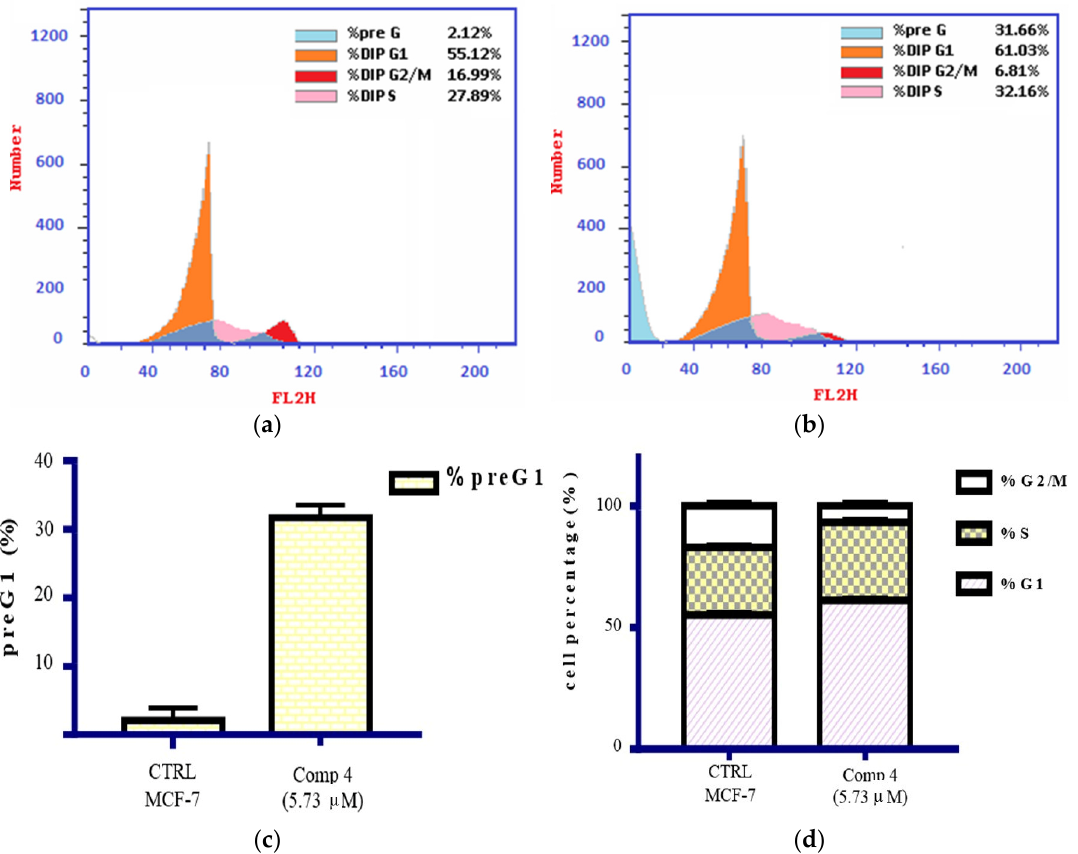
Figure 5. Effect of compound 4 (5.73 µM) on the distribution of MCF-7 cells. ( a , b ) Flow cytometry analysis of the different cell cycle phases of treated and untreated MCF-7 cells. ( c ) Effect of compound 4 on the cellular population in the pre-G1 phase. ( d ) Histogram data of the cell cycle distribution of treated and untreated MCF-7 cells.